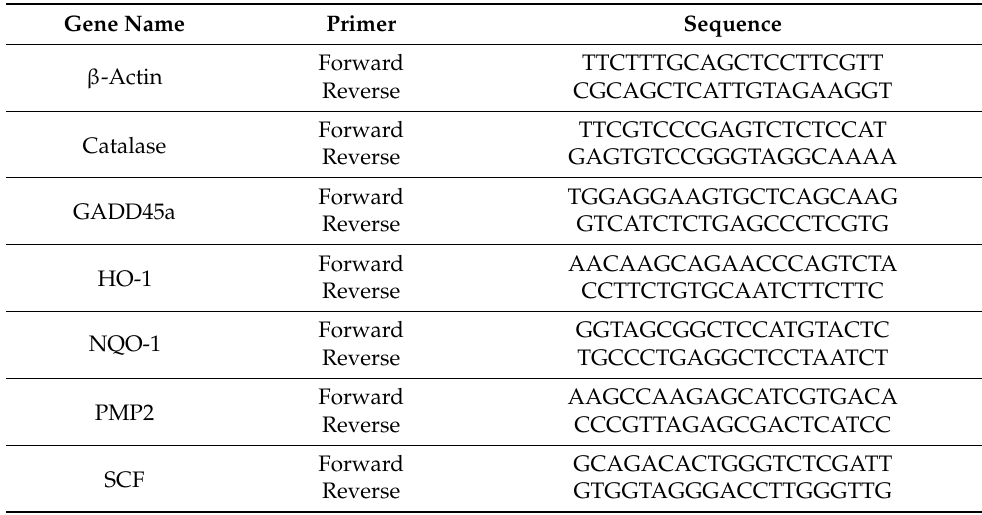
Table 1. A primer list used for PCR